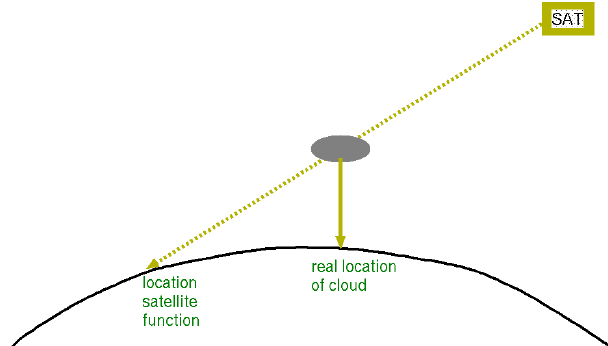
Figure 5. Illustration of the parallax effect.